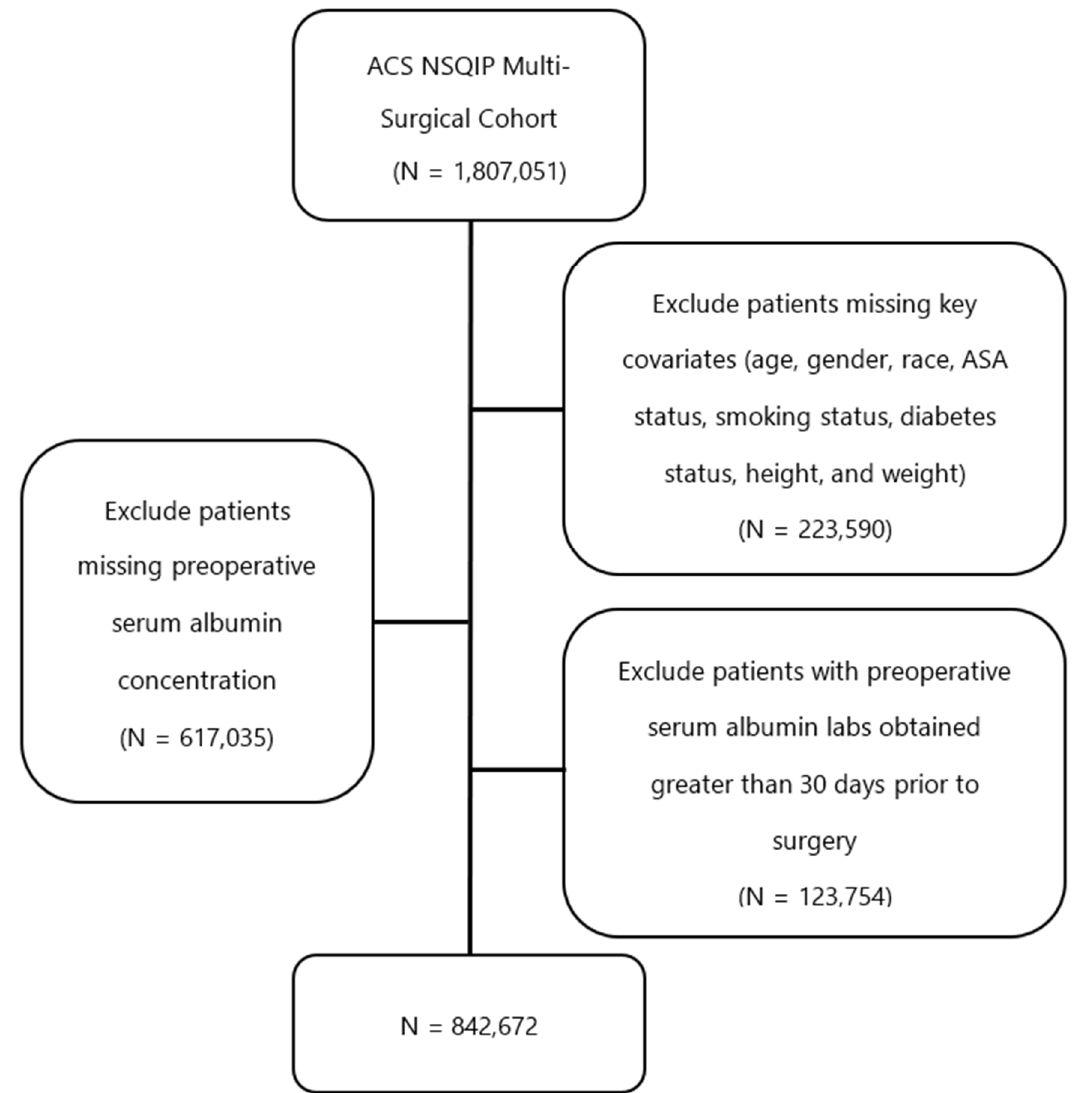
Figure 1. Cohort Creation Algorithm—A total of 842,672 patients were included in the study after excluding patients missing key covariates or missing serum albumin concentration within 30 days of surgery. ACS–American College of Surgeons; NSQIP—National Surgical Quality Improvement Program; ASA—American Society of Anesthesiologists. Table 1. Optimal serum albumin cutoff (g/dL) to predict 30-day postoperative adverse events.